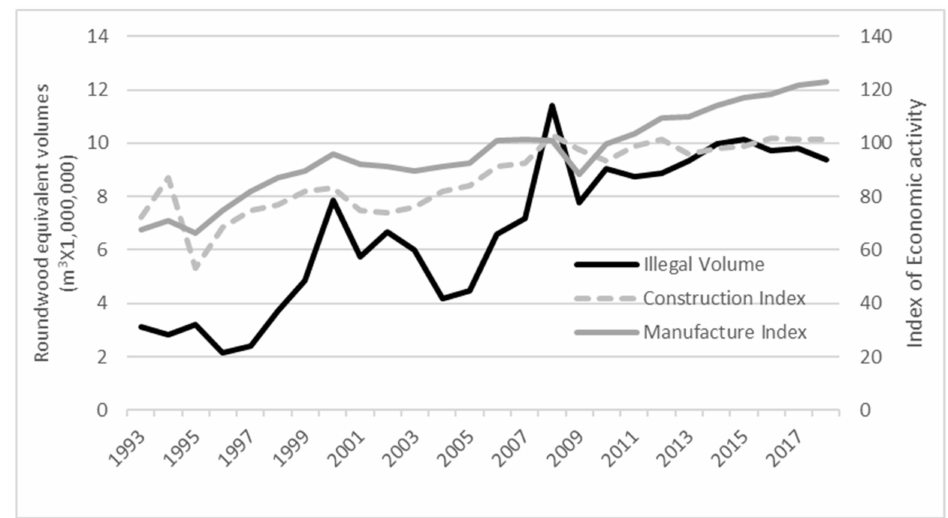
Figure 4. Illegal volume trend compared with manufacturing and construction indexes trends. Illegal volume is measured in the primary y-axis, while manufacture and construction indexes are measured in the secondary y-axis. Indexes represent relative growth of the economic activity from the base year =